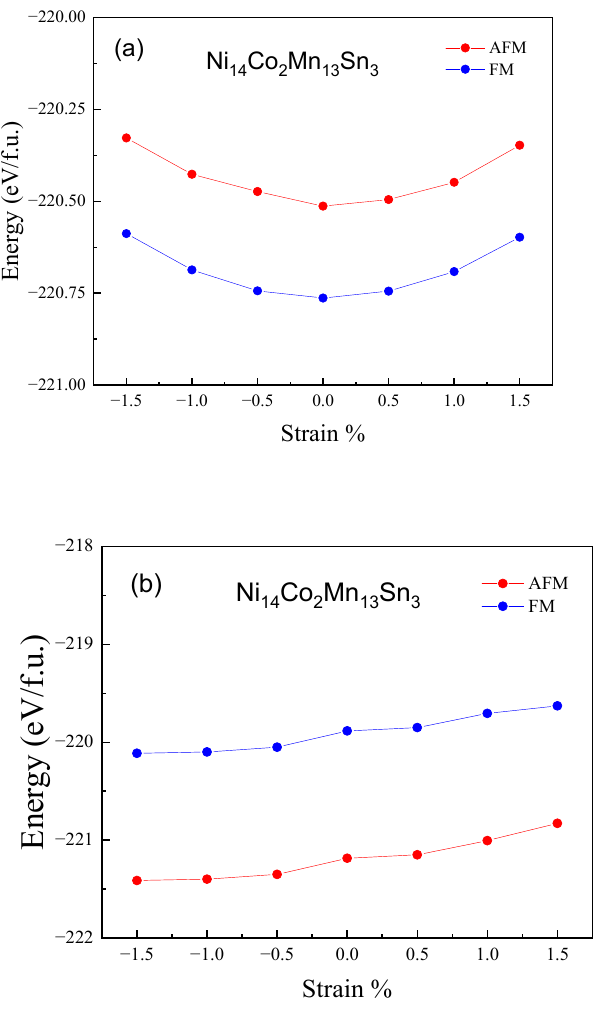
Figure 4. Strain change ( − 1.5~1.5%) of the total energies of Ni 14 Co 2 Mn 13 Sn 3 alloys. ( a ) The austenitic phase. ( b ) the martensitic phase.